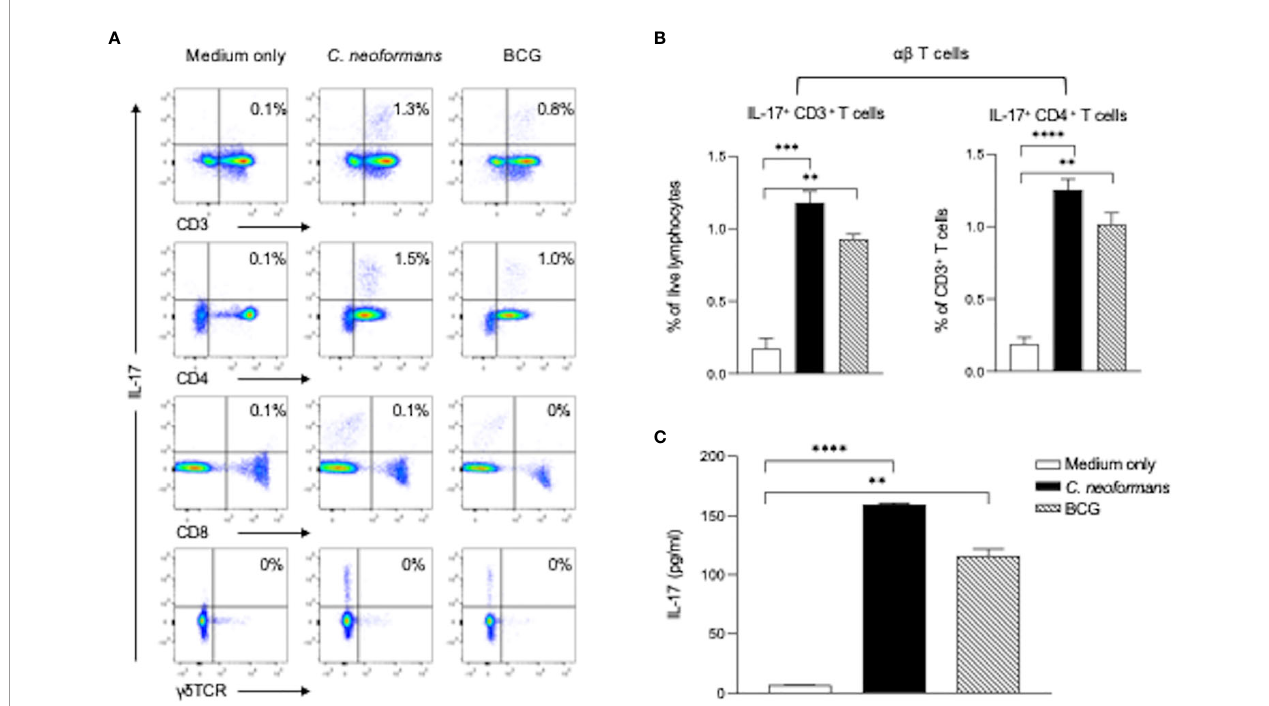
FIGURE 3 | C. neoformans stimulates IL-17 production by CD4 + T cells in vitro. Peripheral blood mononuclear cells were stimulated with C. neoformans or bacillus Calmette – Gue ́ rin for 3 days with protein transport inhibitor cocktail for 5 h before the cells were collected. The IL-17-producing cells were analyzed by fl ow cytometry: representative data of IL-17 + T cells in ab TCR + T cells (CD3 + gd TCR - cells) and gd TCR + T cells (A) and percentages of IL-17 + CD3 + cells in live lymphocytes and percentages of IL-17 + CD4 + cells in live CD3 + cells (B) . The corresponding IL-17 level in the supernatant (C) is shown as mean ± SE of three individual experiments. ** p < 0.01, *** p < 0.001, **** p <